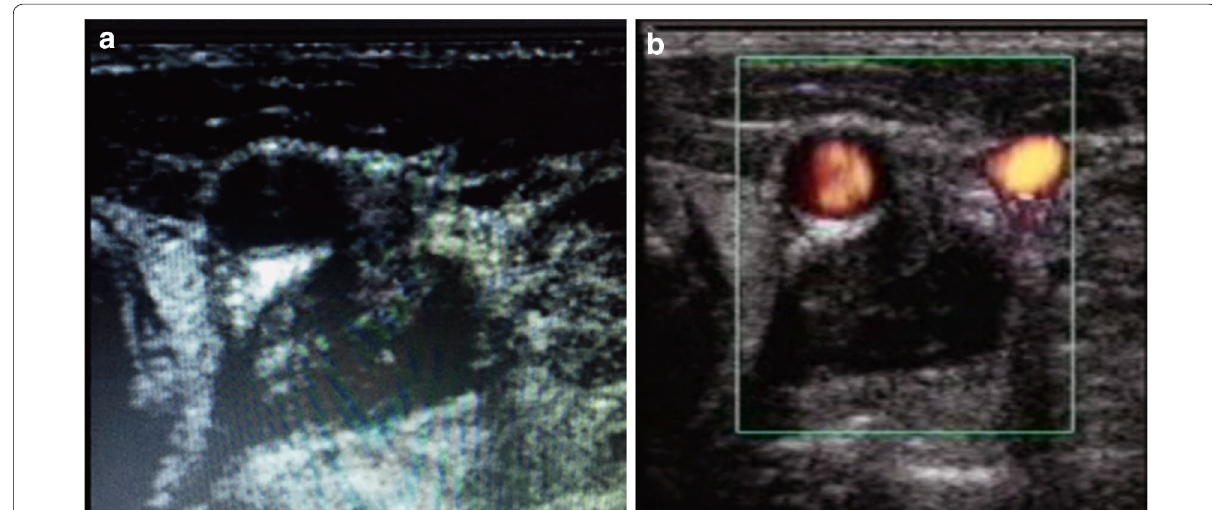
Fig. 4 Perivascular hematoma. Knife penetrating wound in the left side of the neck . a Transverse view of the neck showing an hypoecoic hematoma between carotid and yugular vein. b Power Doppler showing indemnity of carotid and yugular with the hemathoma between the two vessels